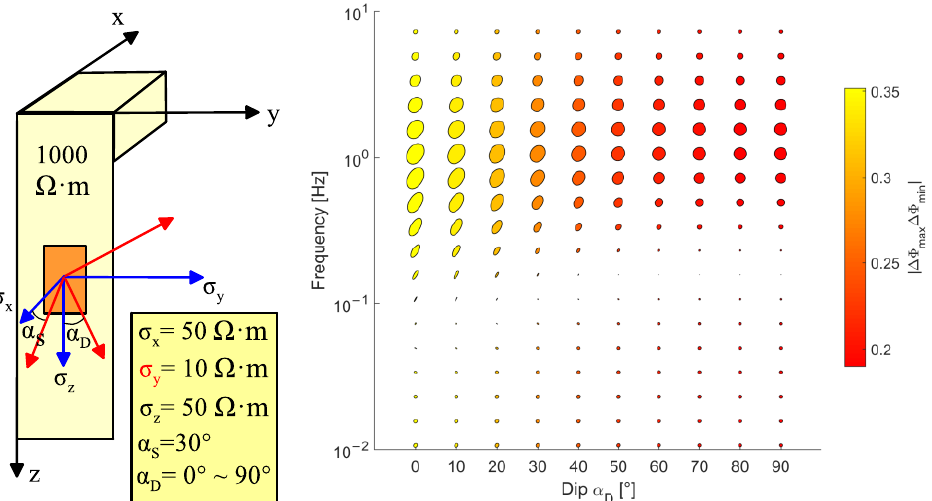
Figure 13. The fracture anisotropy model and the residual phase tensor for different dip angles in the 30° strike angles. 30 ◦ strike